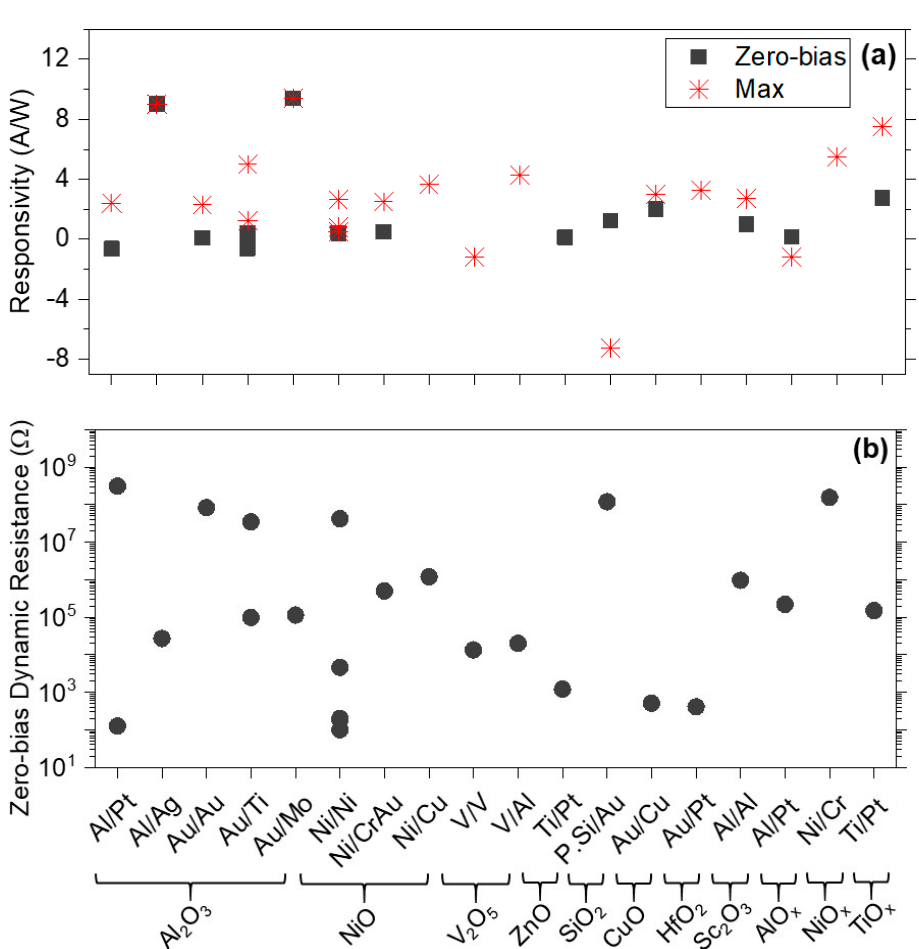
Figure 4. ( a ) Responsivity and ( b ) dynamic resistance for various MIM diodes. Full details are summarized in Table 2.